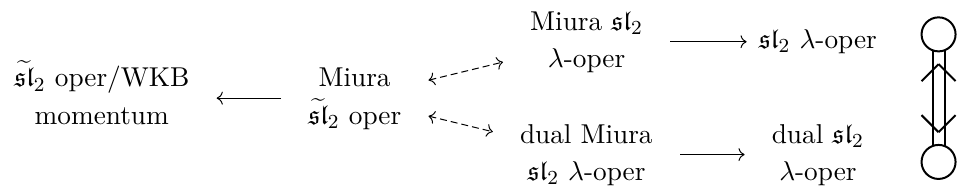
Figure 1 . Different types of opers: the middle dotted arrows are local gauge transformations by diagonal matrices. The right arrows correspond to working modulo gauge transformations by upper and lower triangular matrices of the form (3.13) and (3.16), respectively. The left arrow corresponds to working modulo gauge transformations by matrices of the form